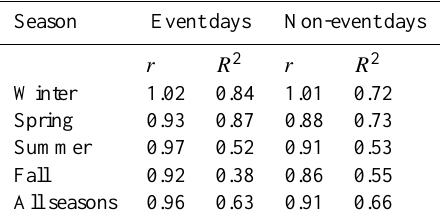
Table 2. Median values of the ratio of positive to negative hourly tion coefficients between positive and negative cluster ions